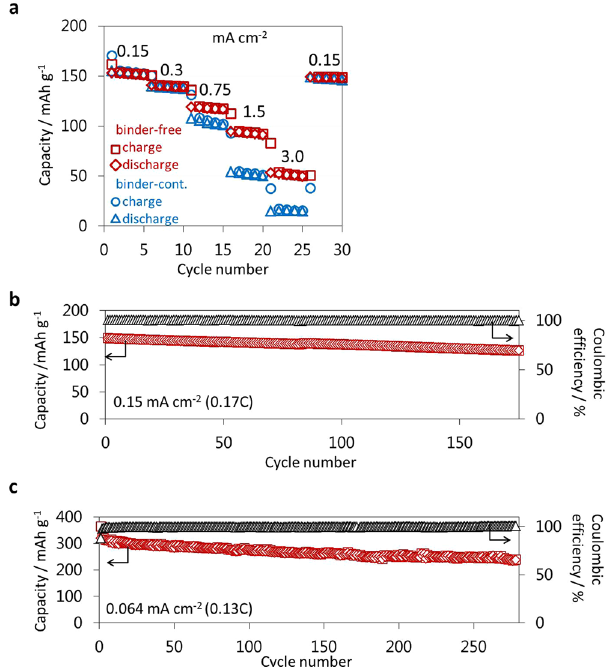
Figure 6. Improved rate and cycle performances of binder-free half-cells. ( a ) Rate capability of the binder- free and binder-containing positive half-cells, (NCM:f-LPS:AB:PPC = 80:20:4:3)/LPS/In-Li, operated at several current densities from 0.15 mA cm − 2 (0.17 C) to 3.0 mA cm − 2 (3.5 C) under CCCV charge-CC discharge between 3.7 and 2.0 V (vs. Li-In) at 30 °C. The numbers denote the operating current densities in mA cm − 2 . Cycling retention of ( b ) binder-free positive half-cell shown in ( a ) operated at current density of 0.15 mA cm − 2 (0.17 C) under CCCV charge-CC discharge and ( c ) binder-free negative half-cell,